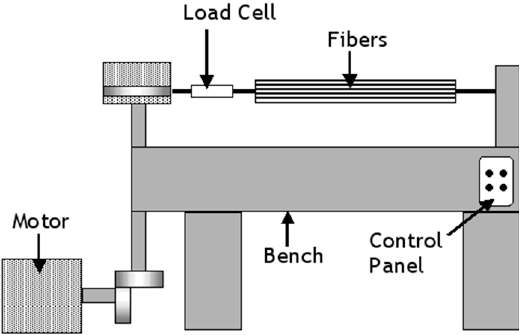
Figure 5. Schematic illustration of the horizontal tensometer-based pre-stressing rig used by Motahhari and Cameron [39].